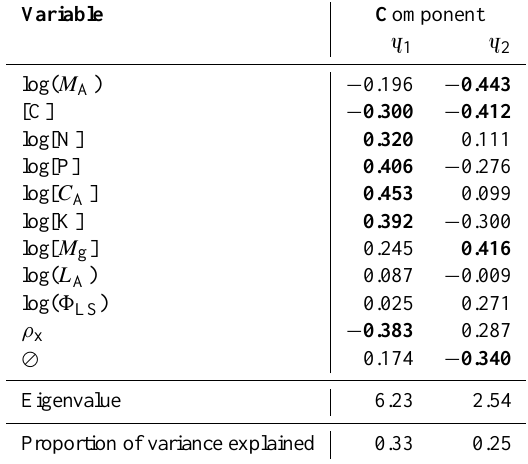
Fig. 7. Euler diagram showing overlaps between the first three dimensions in terms for the individual measured traits (where significant): blue; positive relationship with dimension, red; negative relationship with dimension, black; of different sign depend- ing on the dimension.